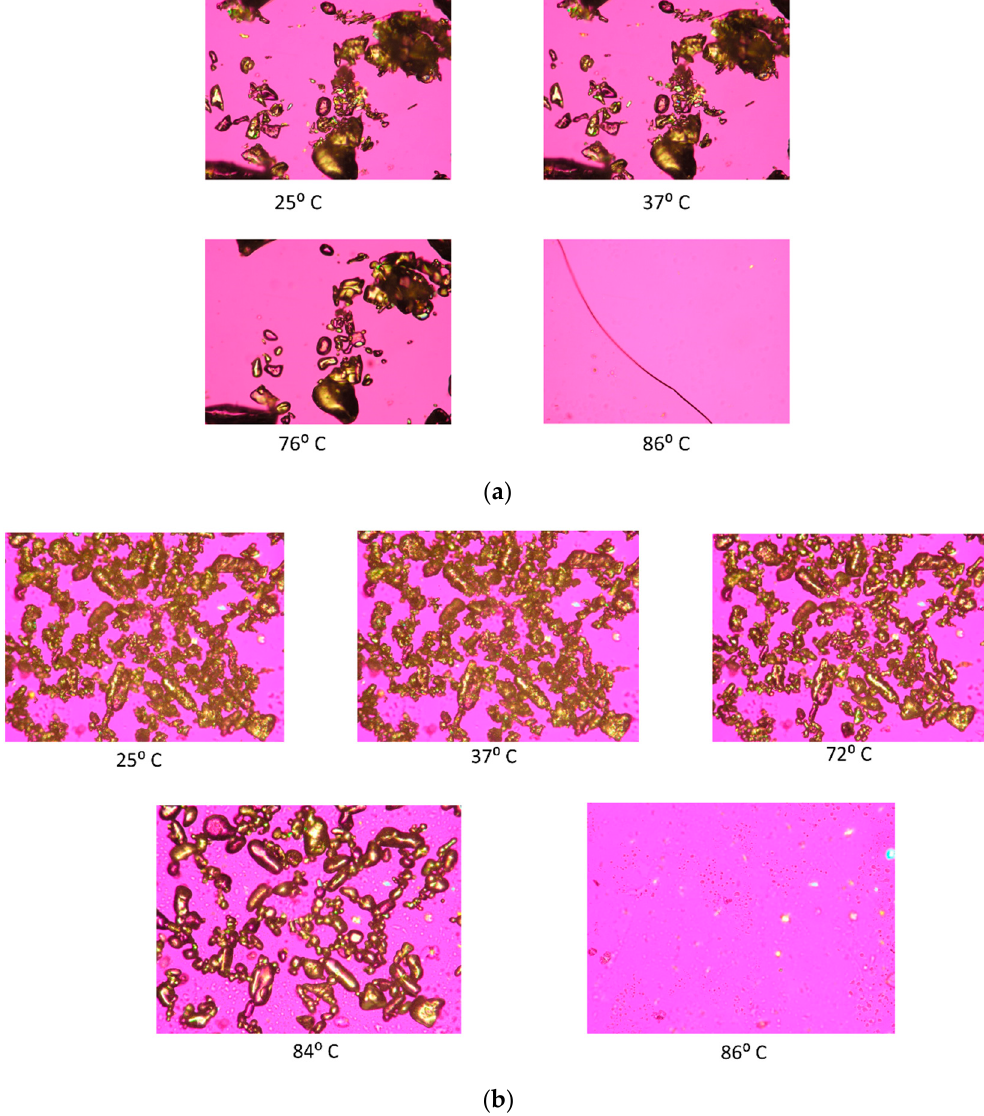
Figure 5. Hot-stage micrographs of ( a ) Raw TMP and ( b ) Spray Dried (SD) TMP.